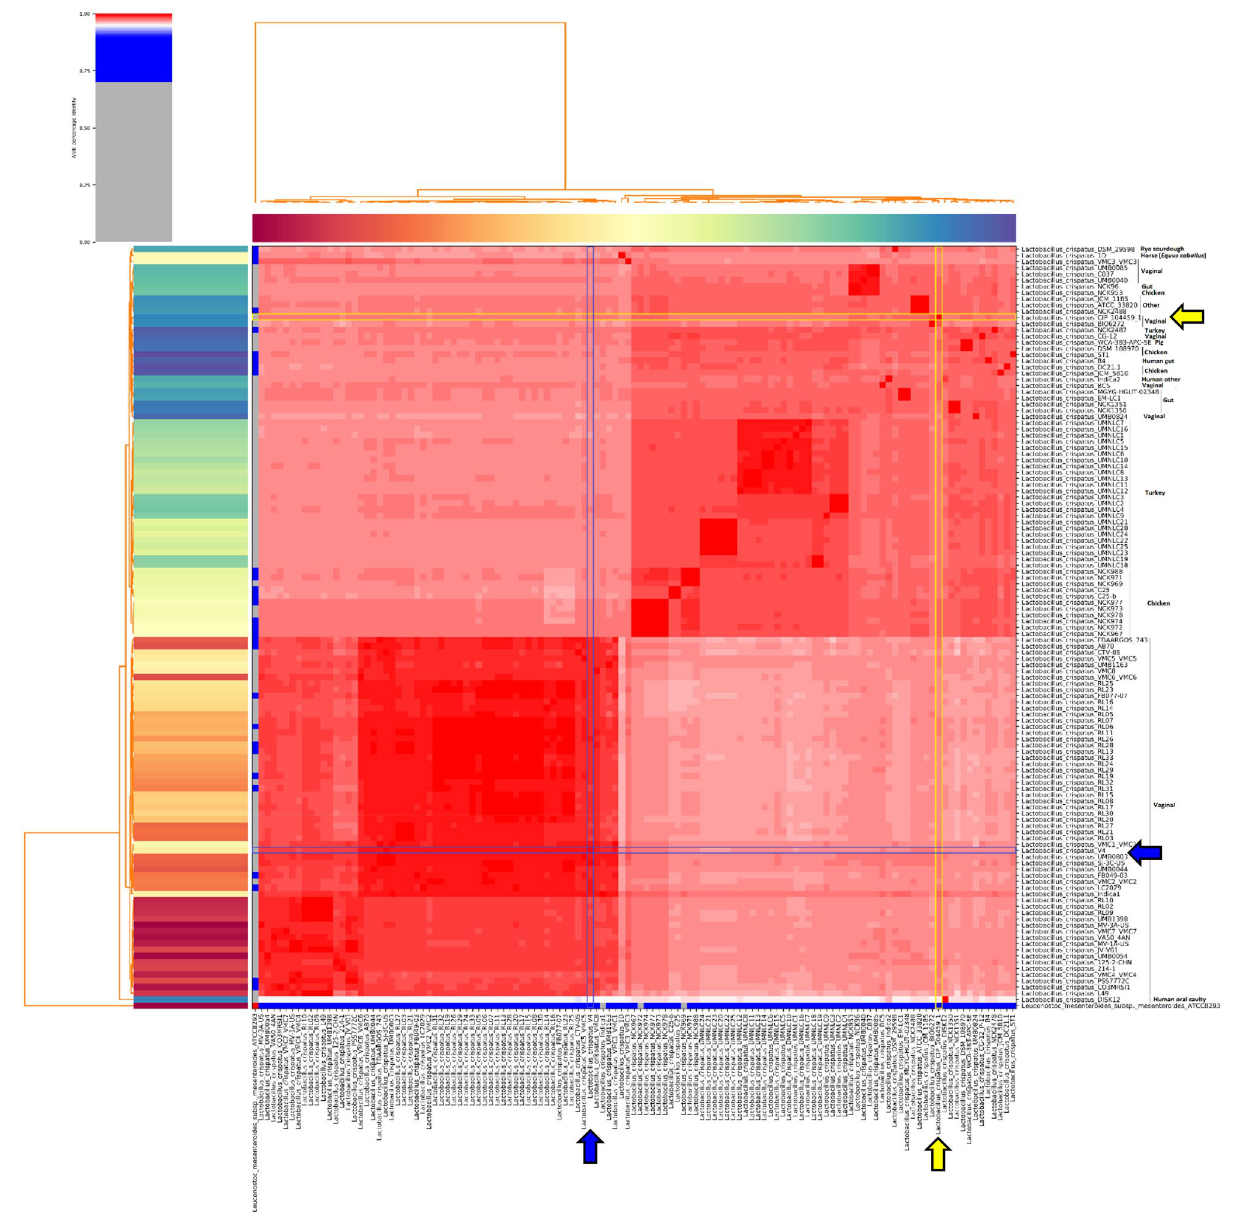
Figure 1. Heatmap and dendrogram of average nucleotide identity (ANI) illustrating the phylogenetic relationships based on the percentage identity [high (red) to low (blue/grey)] shared between the whole sequence of Lactobacillus crispatus V4 (blue boxes and arrows) and 122 other L. crispatus isolates for which the genome sequences were accessible in the NCBI RefSeq database (accessed on 3rd November, 2020), including that of Lactobacillus crispatus CIP104459 from Clabaut et al . 12 (yellow boxes and arrows). The phylogenic tree was rooted using the genome sequence of an unrelated bacterial species, presently Leuconostoc mesenteroides subspecies mesenteroides,